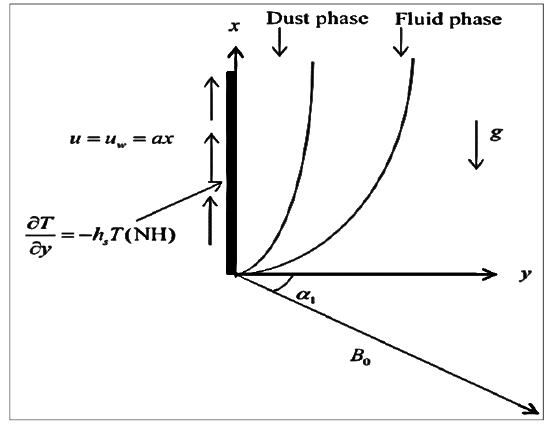
Figure 1. Flow of physical configuration.